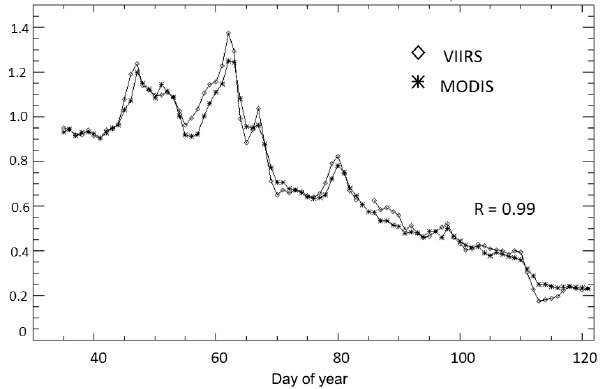
Figure 9. Time series showing differences in snow-cover ex- tent (SCE) derived from Terra MODIS and S-NPP VIIRS cloud- gap-filled (CGF) snow maps for a nearly 3-month period extending from 4 February to 30 April 2012 for the western US/southwestern Canada study area. Although the time series began on 1 February, snow-cover extent from 1 to 3 February is not shown because, in this example, the gap-filling algorithm was started on 1 February and had not filled most of the gaps from clouds until 4